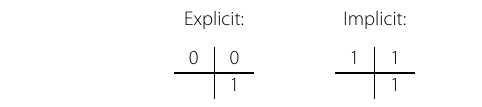
Table 2 Butcher tableaus for the 1st-order IMEX method (Sect. 5.3.3)